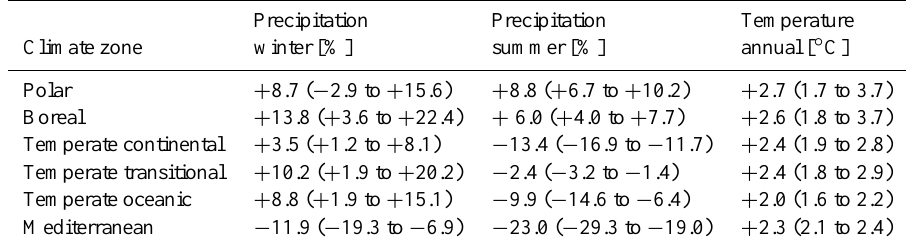
Table 3. Mean change in climate variables for the different climate zones of Europe derived from the ensemble mean. The brackets contain the range of the three climate